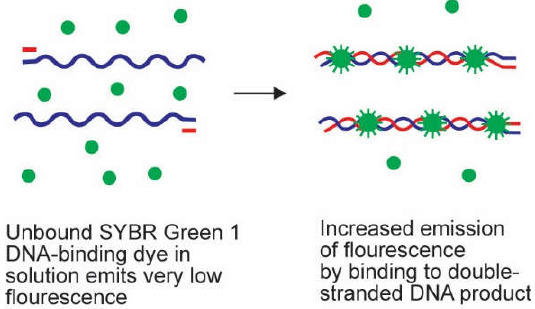
Figure 2. Mechanism of action of SYBR Green 1 dye. SYBR Green 1 probe is a double-stranded DNA-intercalating agent which exhibits very little fluorescence whilst free in solution. In the time of primer elongation and polymerization, SYBR Green 1 molecules become inserted into the double-stranded amplicons, causing an increase in detectable fluorescence [5].